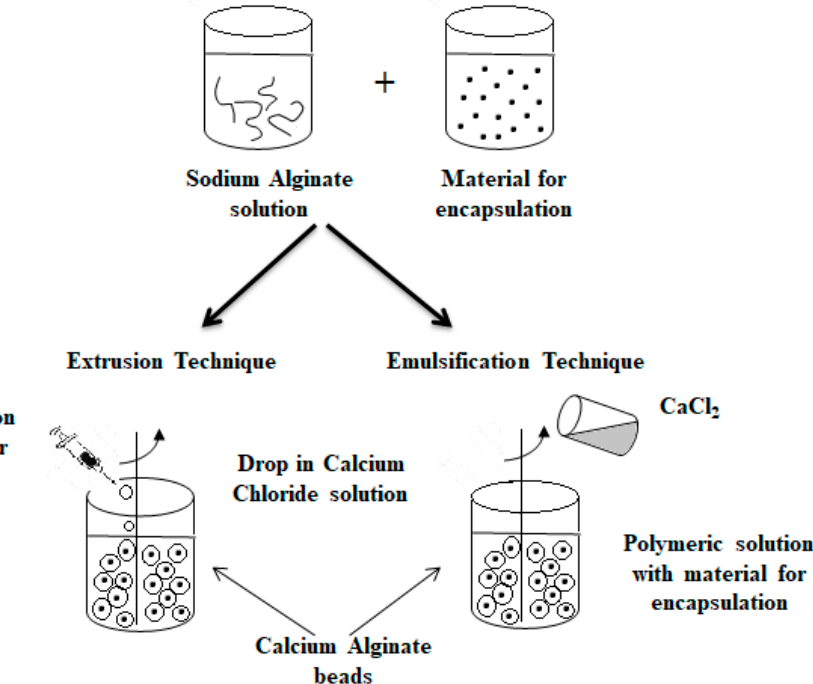
Figure 4. Scheme of the encapsulation process by extrusion (on the ( left )) and by emulsification technique (on the ( right )).